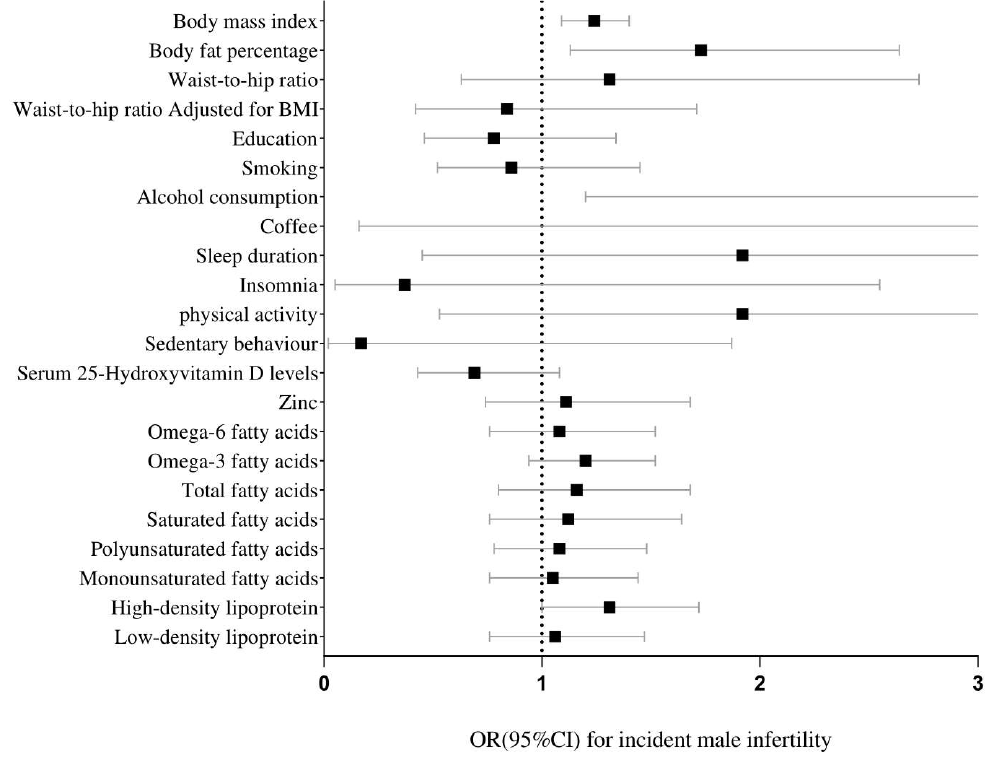
Figure 2. Forest plot of MR analysis between modifiable risk factors and male infertility.